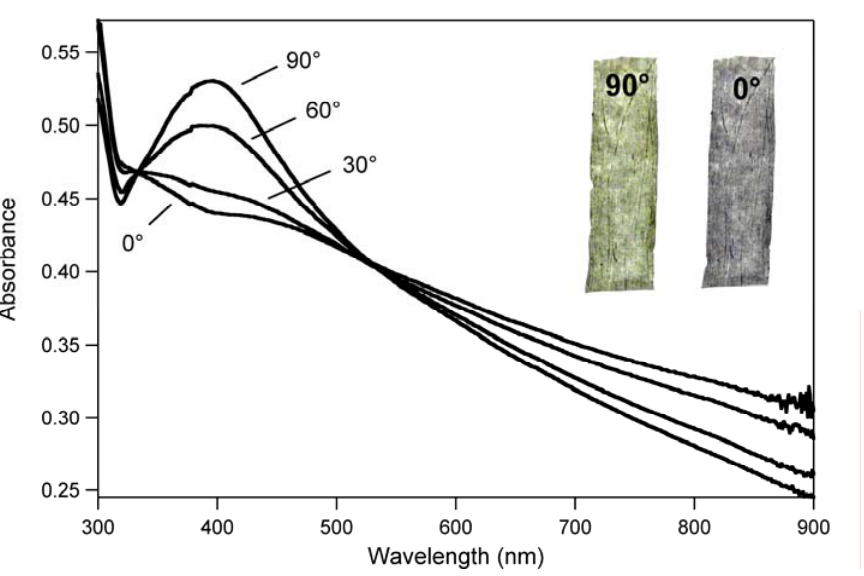
Figure 12. UV-Vis absorption spectra of an oriented PVA@AgNW film as a function of the angle between the polarization of light and the drawing direction of the fi lm, and images of the same film observed through a linear polarizer with the transmission axis parallel (0°) and perpendicular (90°) to the drawing direction